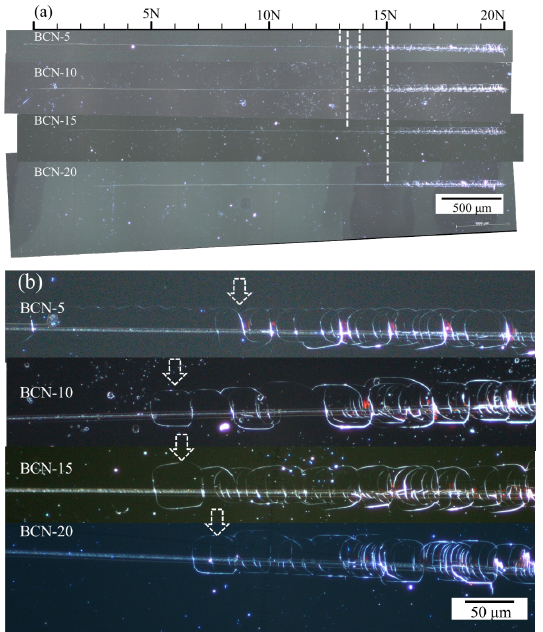
Figure 4: Optical micrographs of scratches (a) and corresponding amplification optical photographs (b) by a scratch tester.